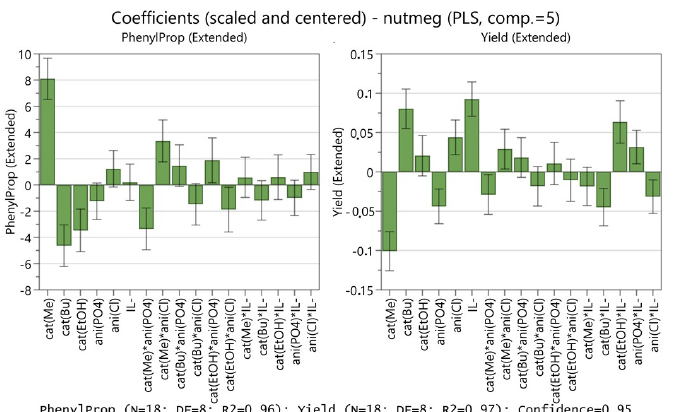
Figure 4. Plot of coefficient values for centered and scaled factors, which was obtained from partial least squares fitting (PLS) for the two response variables studied.